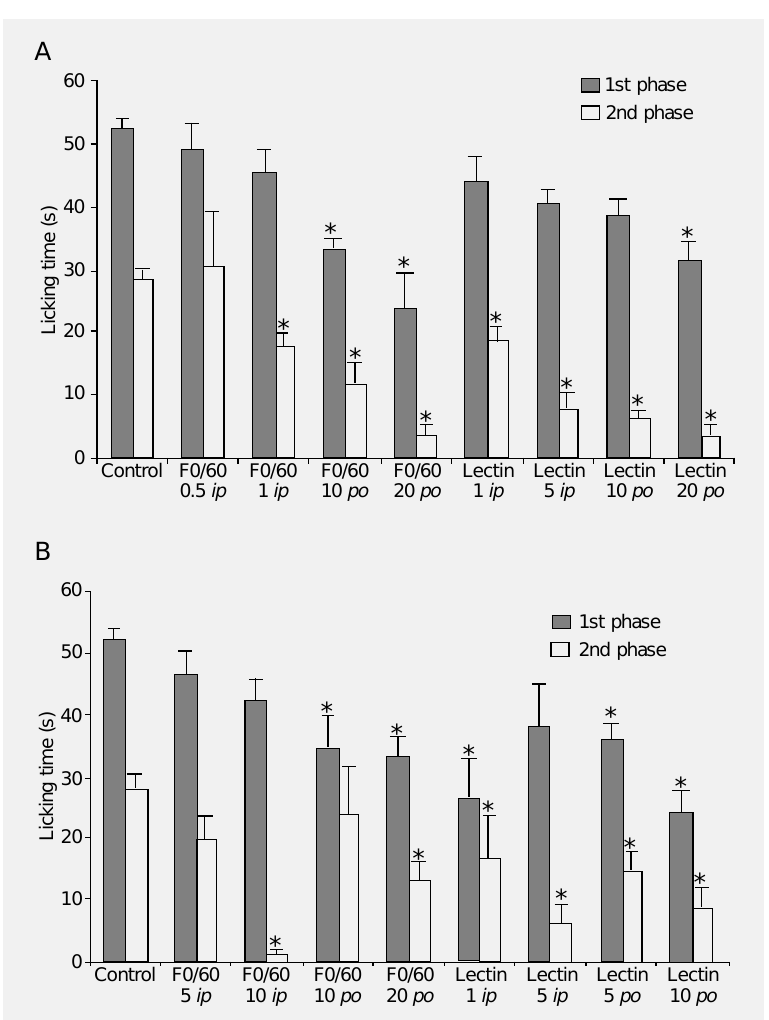
Figure 1. Effects of the crude F0/60 and lectin fractions from Bryothamnion seaforthii (A) and B . triquetrum (B) on the formalin test in mice. Licking time (± SEM) from 6 to 38 mice. Animals received fractions 30 ( ip ) or 60 ( po ) min before the intraplantar administration of 1% formalin, and measurements were done during the first 5 min (1st phase) and after 20 min (2nd phase) for 5 min each. Numbers under fractions indicate dose in mg/kg and route of administration. *P<0.05 vs control (ANOVA and Dunnett as a post hoc